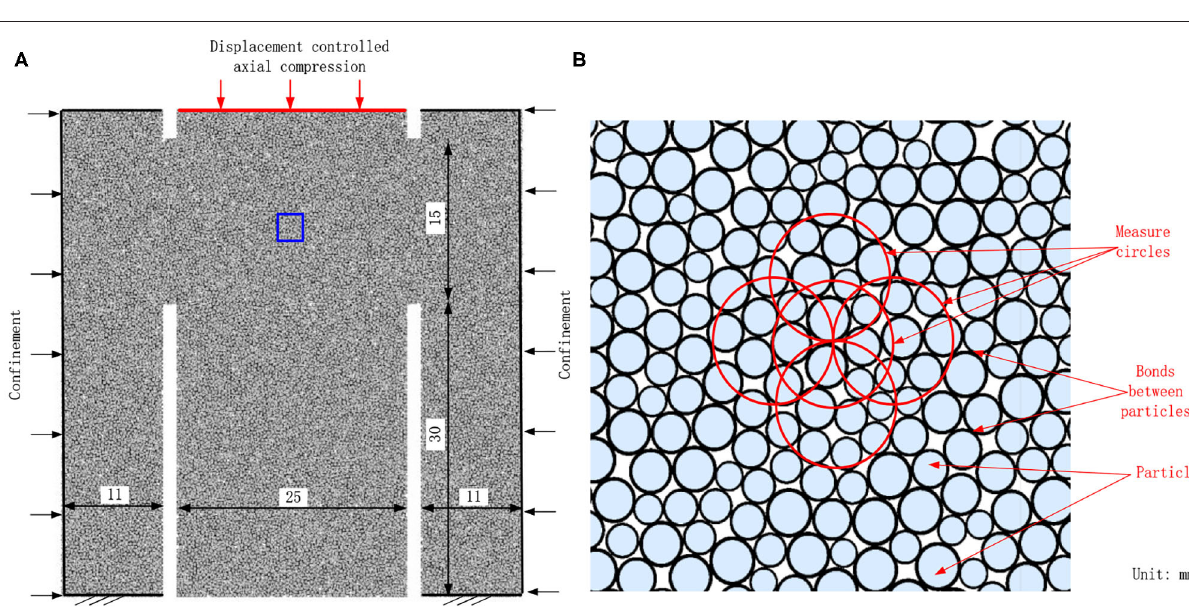
calculated effective shear fracture toughness is 4.37 MPa ∗ m 1 / 2